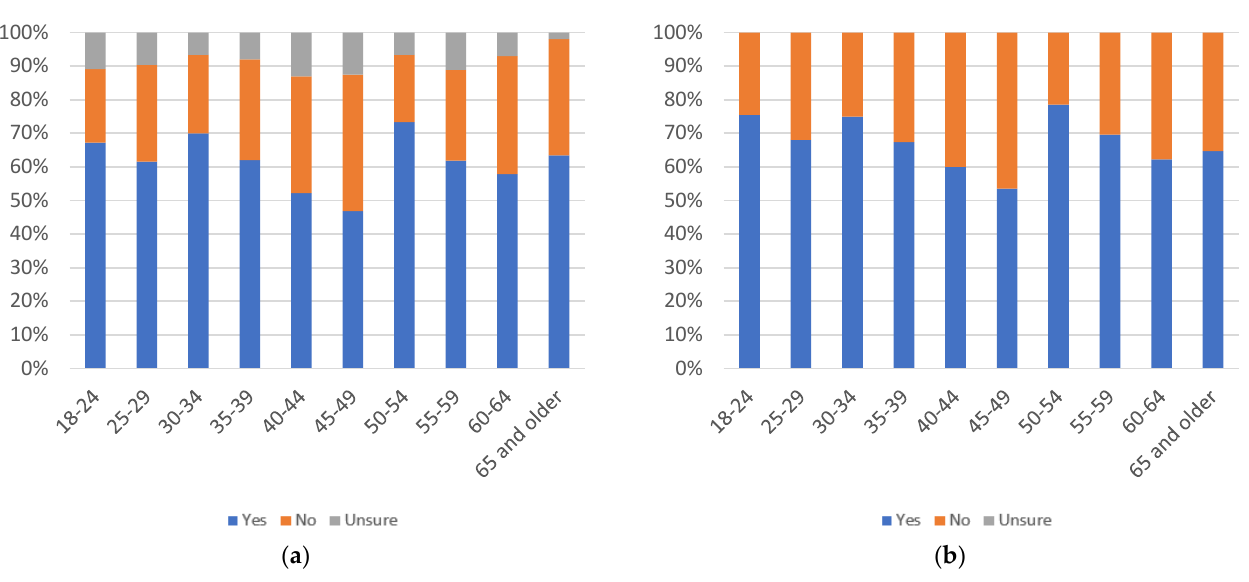
Figure 85. Label helpfulness, by age group: ( a ) with uncertain respondents (left) and ( b ) without uncertain respondents (right).